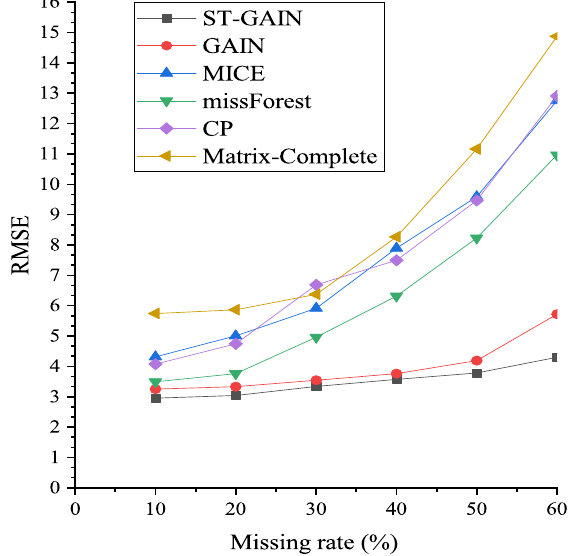
Figure 10. RMSE for different miss rates.